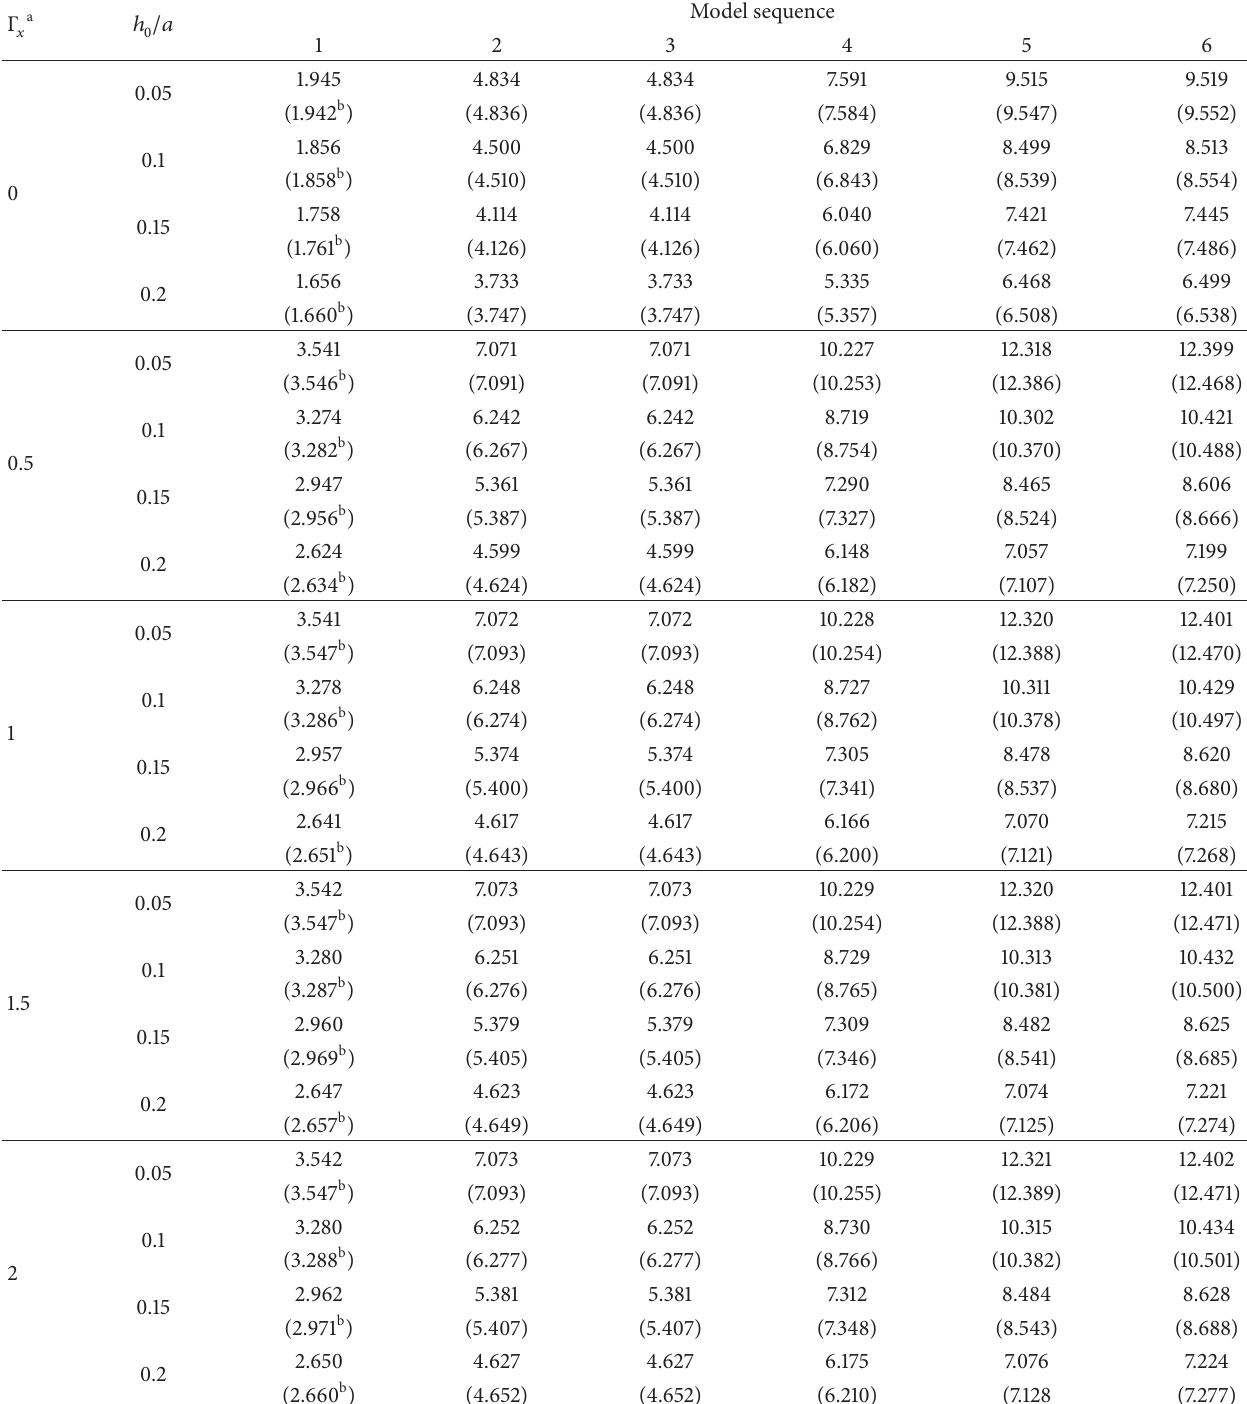
Table 3: Frequency parameters Ω = 𝜔𝑏 2 (𝜌ℎ/𝐷) 1/2 /𝜋 2 for S-S-S-S moderately thick plates ( 𝑎 / 𝑏 = 1 ) with uniform thickness and elastic rotation support ( 𝐾 𝑥0 = 𝐾 𝑥𝑎 = 𝐾 𝑦0 = 𝐾 𝑦𝑏 = Γ 𝑥